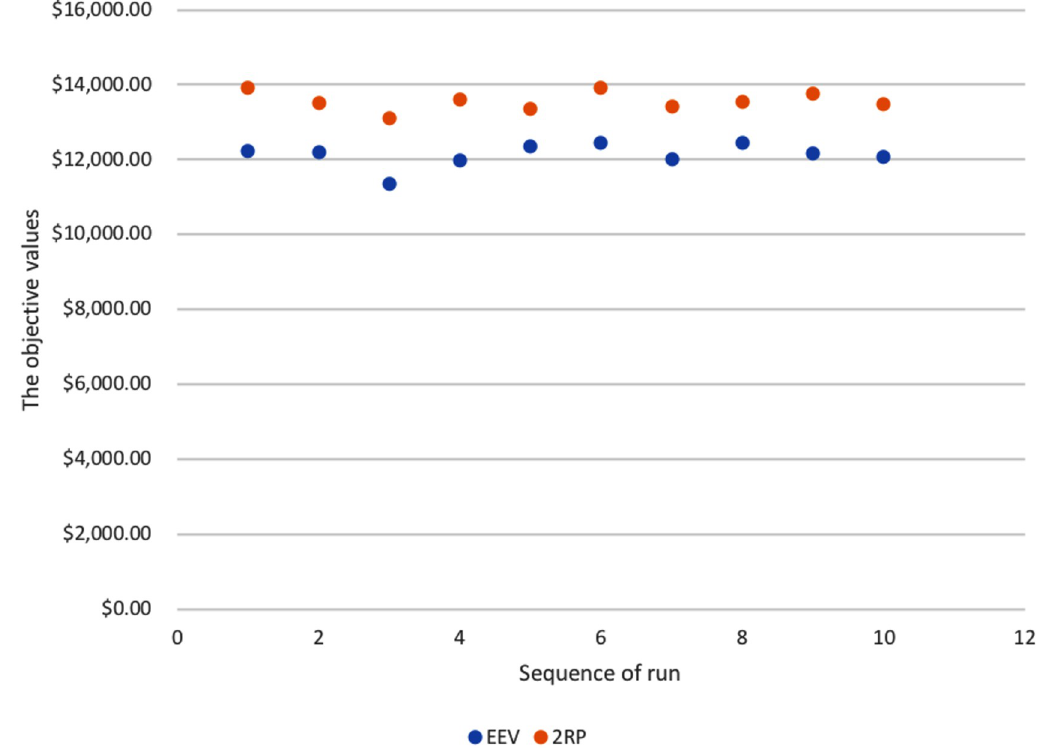
Fig 4. The objective values of two-stage RP and EEV for ten runs